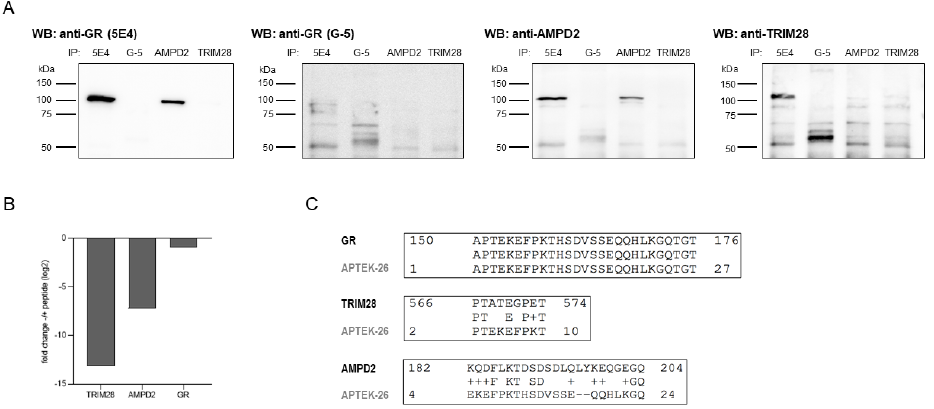
Figure 3. Re-evaluation of anti-GR (5E4) antibody specificity. ( A ) Comparison of target proteins by western blot analysis. Pull-down samples from HEK293 whole cell lysates were obtained by immunoprecipitation using the following antibodies: anti-GR (5E4), anti-GR (G-5), anti-AMPD2 (QQ13), and anti-TRIM28 (Cat# PA5-27648). The protein content was visualized by incubation with primary antibodies directed against GR (5E4, biotinylated), GR (G-5, biotinylated), AMPD2 (PA5-26127, biotinylated), and TRIM28 (Cat# PA5-27648) as indicated, followed by HRP-conjugated streptavidin and anti-rabbit IgG antibody as secondary reagents. ( B ) Mass spectrometric analysis of pull-down samples obtained by IP from HEK293 whole cell lysates using the anti-GR antibody, 5E4, with and without prior two-hour incubation with APTEK-26 peptide. Bar graphs show fold change of peptide incubation to without peptide incubation. ( C ) Amino acid sequences of the newly identified anti-GR (5E4) target proteins, AMPD2 (UniProt ID: Q01433) and TRIM28 (UniProt ID: Q13263), were blasted against the APTEK-26 peptide using NCBI Protein BLAST (https://blast.ncbi.nlm.nih.gov/Blast.cgi, accessed on 14 th November 2020) [13].